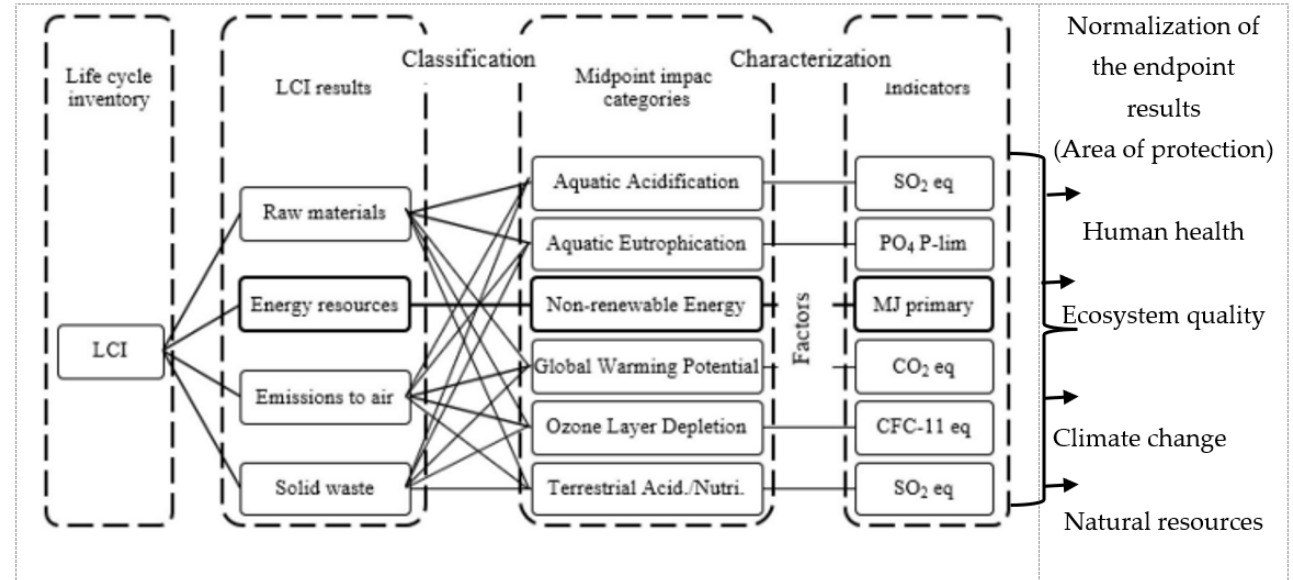
Figure 8. The framework of midpoint analysis, as one of the Impacts 2002+ methods (derived from [45]).